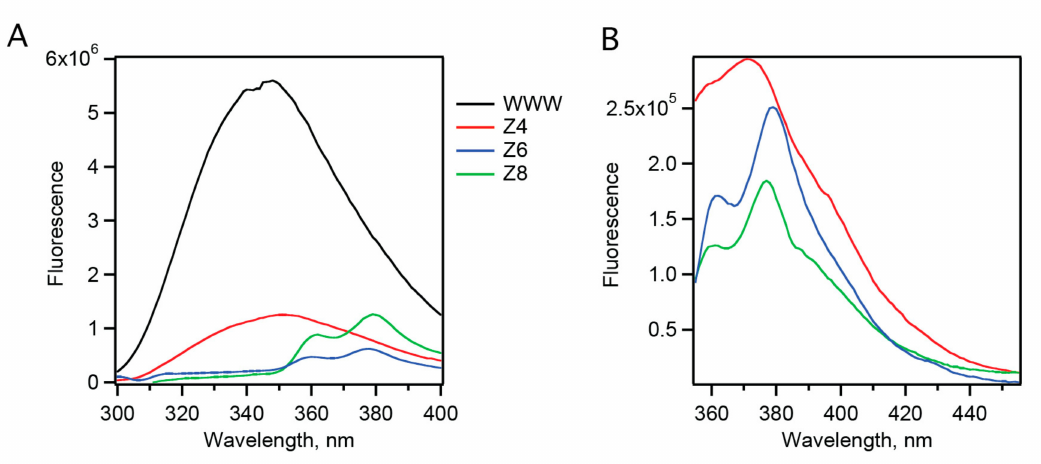
Figure 4. Fluorescence emission spectra of peptides when excited at 280 nm ( A ) and 342 nm ( B ). Conditions: [peptides] = 2 µ M, buffer = 50 mM phosphate, 150 mM NaCl, pH 7.0.